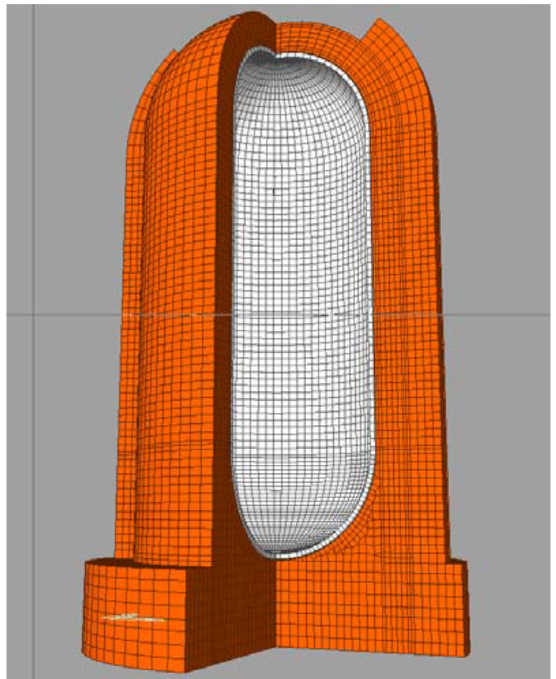
Figure 5. Tendon rings established in the accumulation tank.